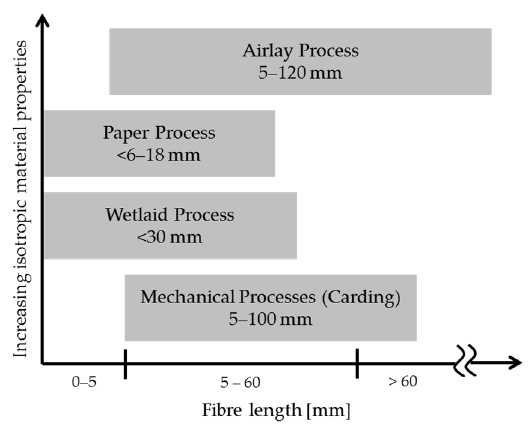
Figure 3. Manufacturing processes for nonwoven in relation to fibre length and degree of isotropic material properties. Figure based on [35].